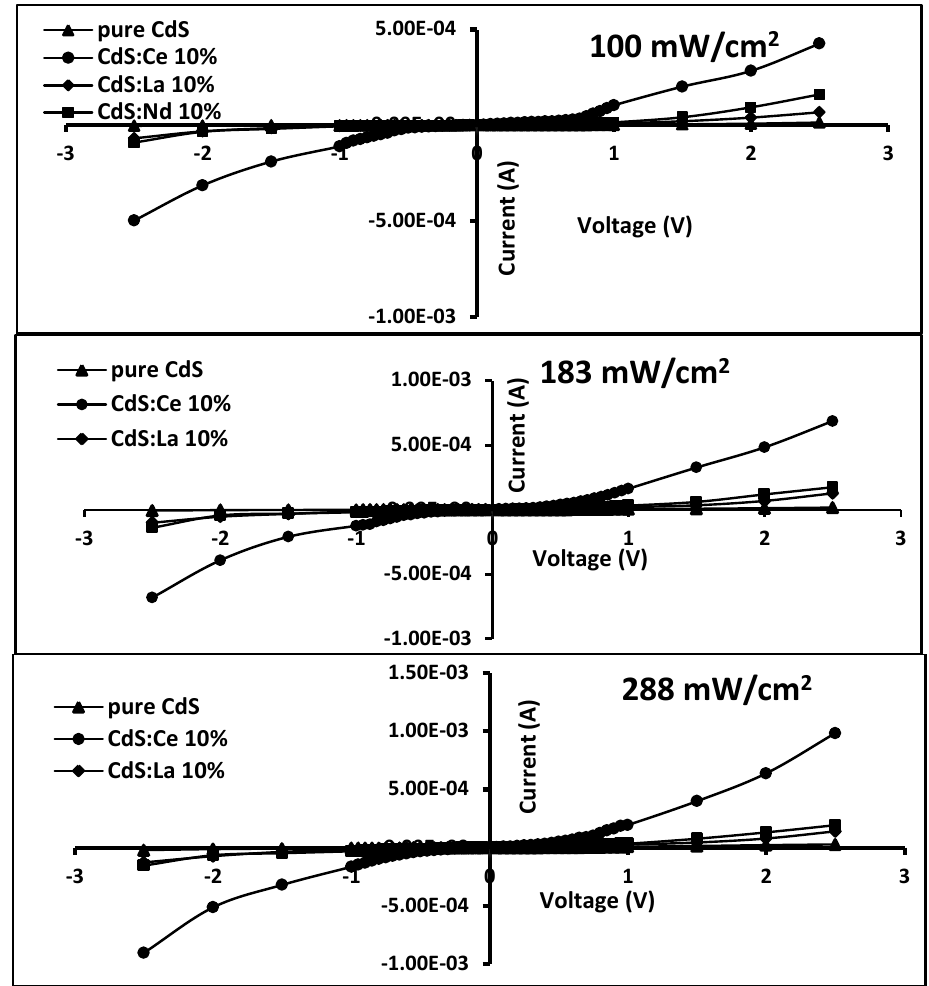
Fig.8: I-V characteristics of CdS and (Ce, La and Nd) doped CdS at 10% in light condition.